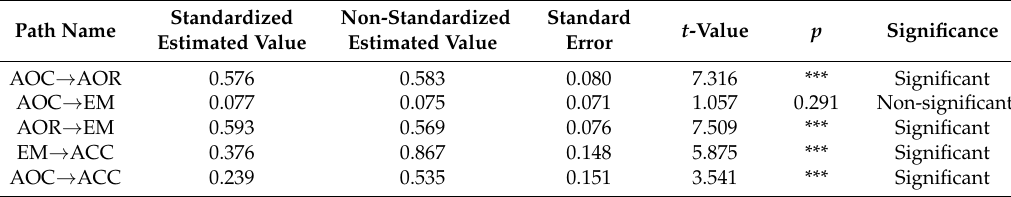
Table 10. Path coefficient for the structural